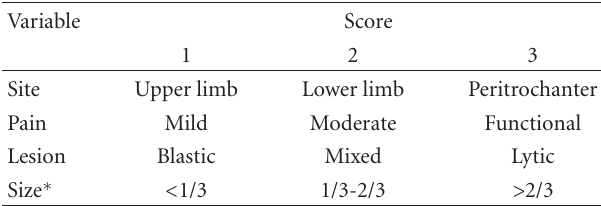
Table 1: Mirels’ Scoring